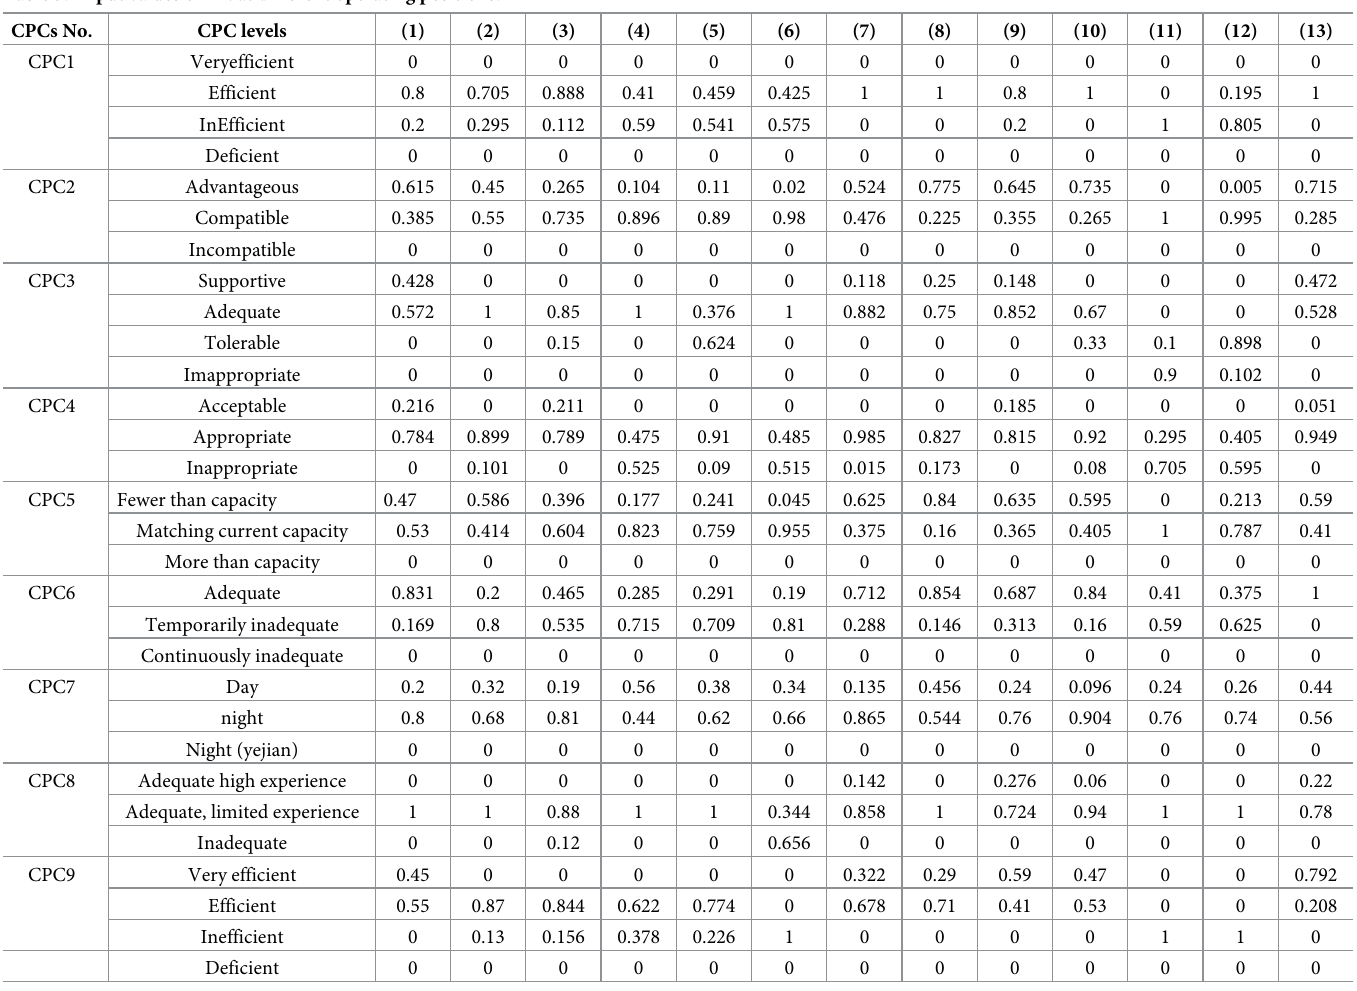
Table 5. Input values of BN at different operating positions. CPCs